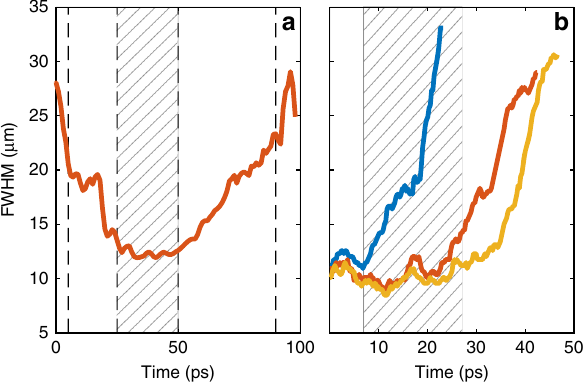
Fig. 6 Soliton compression effect. a Five-picosecond excitation pulse, P = 100 μ W. FWHM vs. time, showing the initial threefold compression and the subsequent expansion of the pulse. Black dashed vertical lines indicate times (5, 25, 50 and 90 ps) corresponding to the real-space images shown in Fig. 5c – f. b Two-picosecond excitation pulse. FWHM vs. time at different excitation powers (blue: P = 30 μ W; red: P = 250 μ W; yellow: P = 400 μ W). Time t = 0 corresponds to the excitation pulse